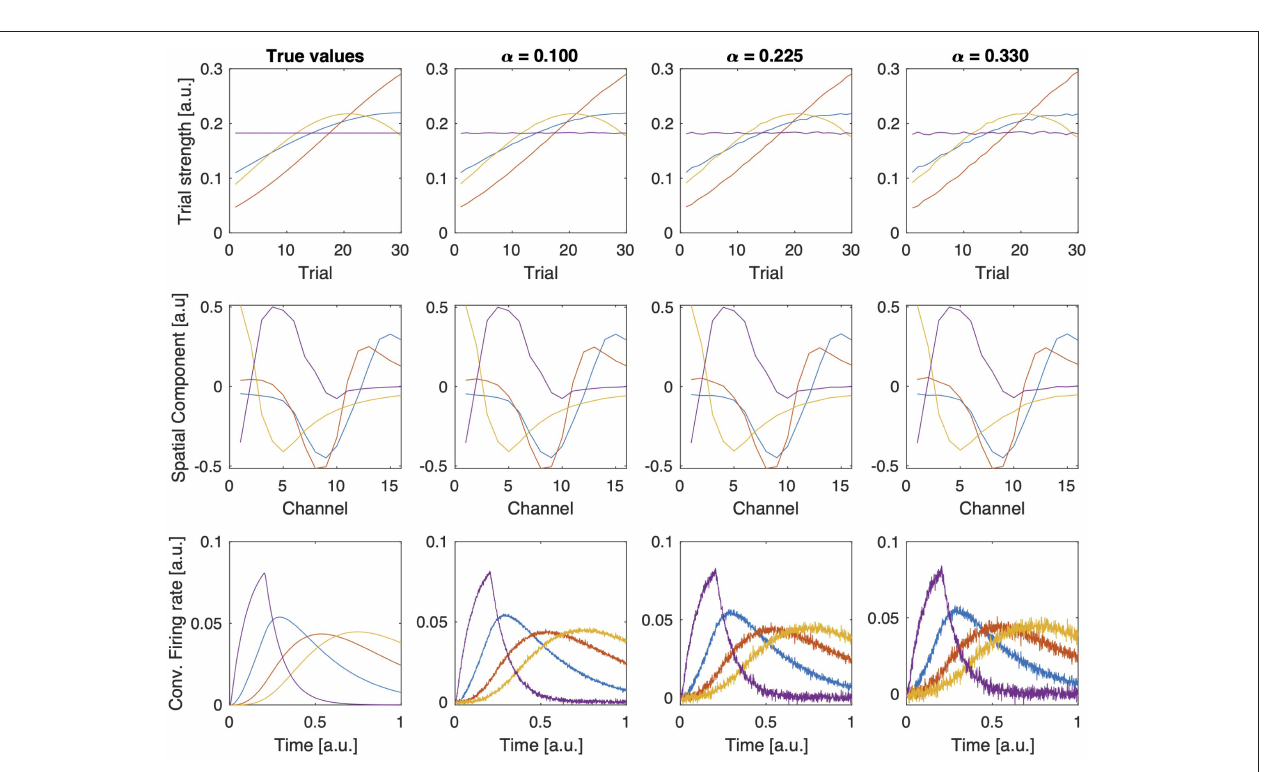
FIGURE 4 | Factor vectors in each mode of a 4-component CP model of tensors with different noise levels ( α